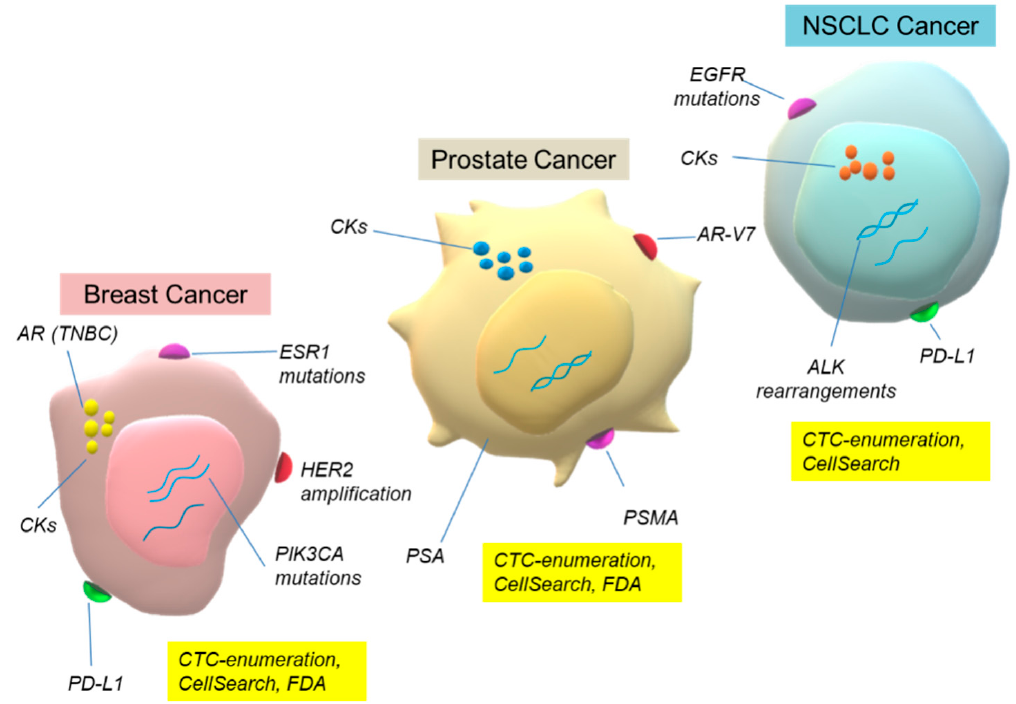
Figure 2. Main biomarkers detected in CTCs of breast, prostate and NSCLC.